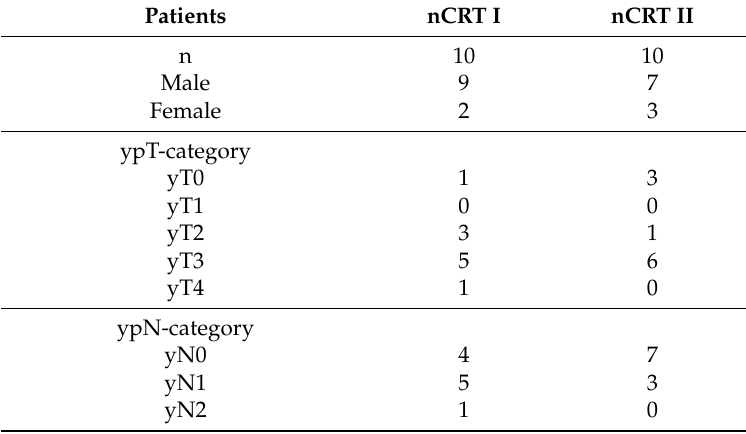
Table 2. Patients and histopathological tumor characteristics of rectal adenocarcinomas which underwent laser capture microdissection and proteome analysis by isotope coded protein label